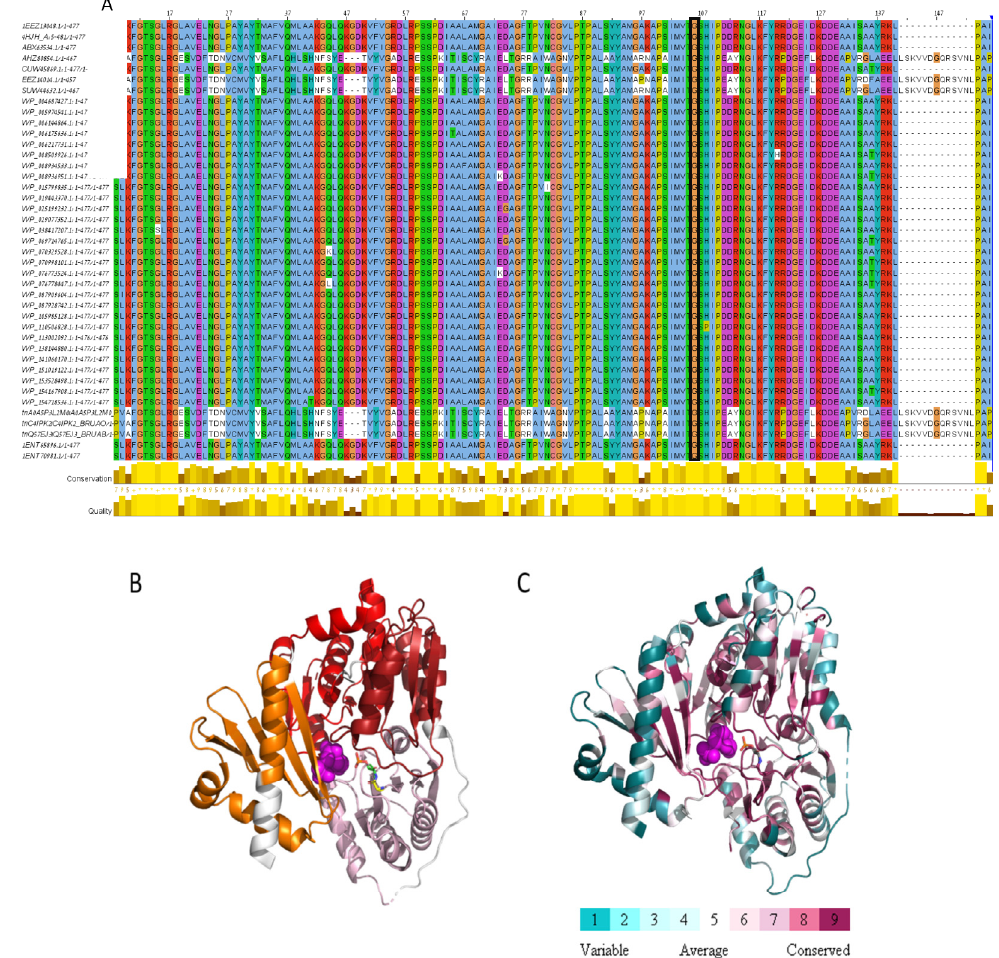
Figure 3. Missense mutation within Phosphomannomutase. ( A ) MSA of 41 Brucella Phosphomannomutase sequences. Only the first Phosphoglucomutase-phosphomannomutase (PGM-PMM)_is presented (residues 1–140). Gly103, marked by black rectangle, is conserved through all homologs. ( B ) The protein domains are shown on the model structure of glutathione S-transferase (PGM-PMM-I in pink, PGM-PMM-II in dark red, PGM-PMM-III in red, PGM-PMM-IV in orange). Glucose-6-phosphate in magenta spheres, catalytic phospho-histidine 104 in green carbons, Glycine 103 in yellow carbons. ( C ) PGM/PMM is colored according to conservation. Glucose-6-phosphate in magenta spheres. Positions 103 and 104 in sticks. This analysis is based on 150 homologous sequences from Uniref90.